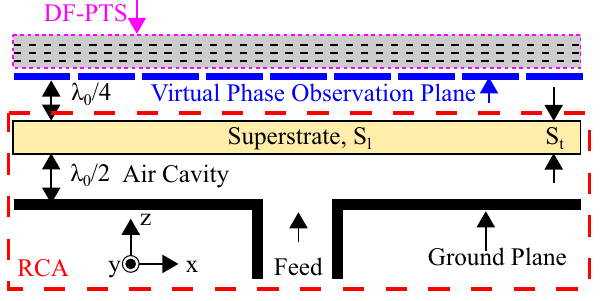
Figure 3. Cross section of the proposed antenna system where DF-PTS is placed in the virtual plane defined parallel to the RCA in the near-field